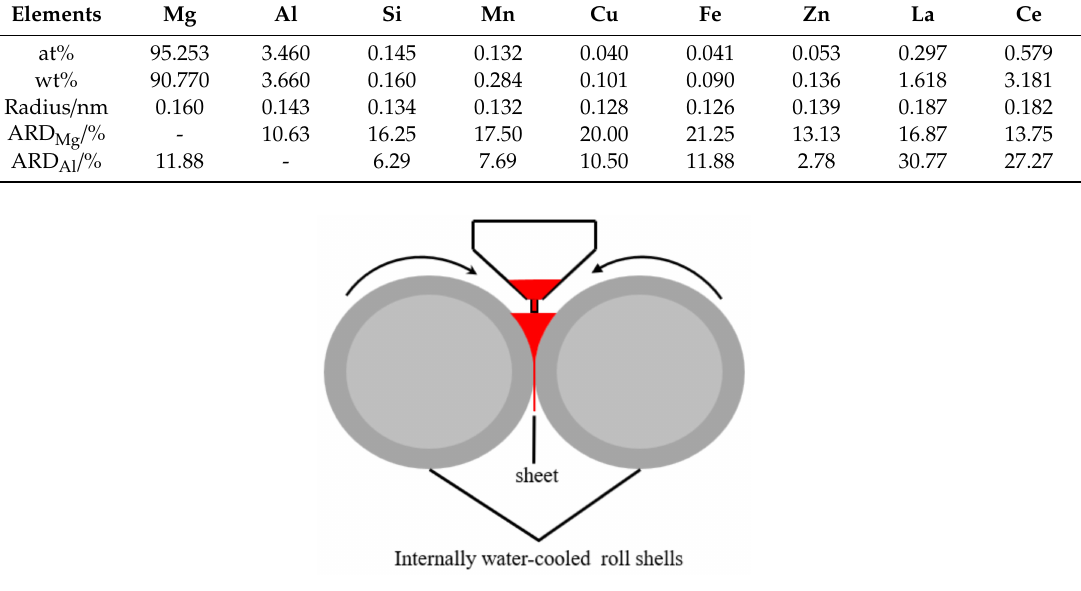
Figure 1. Schematic diagram of the manufacturing process for magnesium alloy